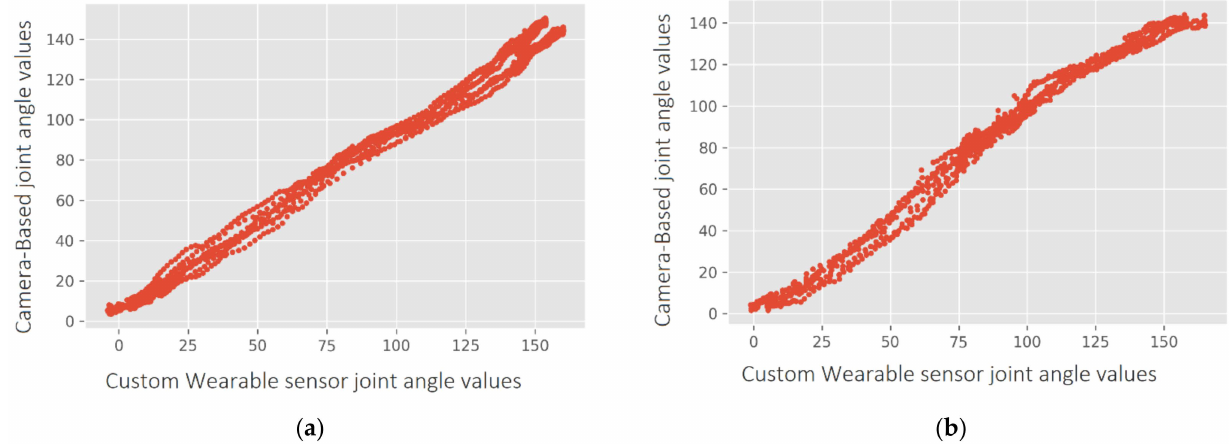
Figure 10. Elbow joint computed angles correlation (camera-based vs. Custom Wearables system): ( a ) Right elbow test correlation graph; ( b ) Left elbow test correlation